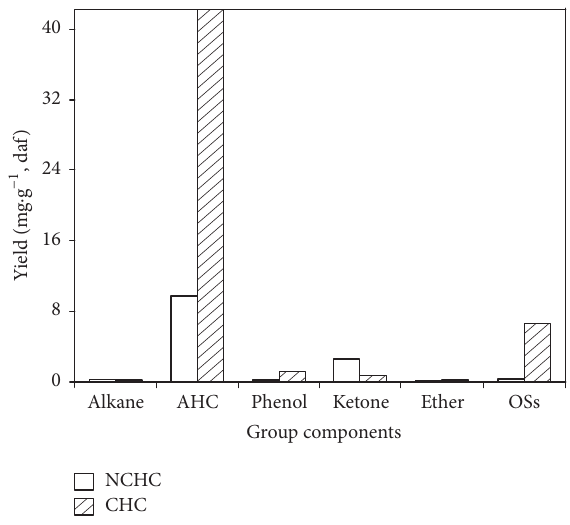
Figure 4: Distribution of group components in the reaction prod- ucts from NCHC and CHC of HLR. Table 2: Alkanes detected in the reaction product from NCHC and CHC of HLR.